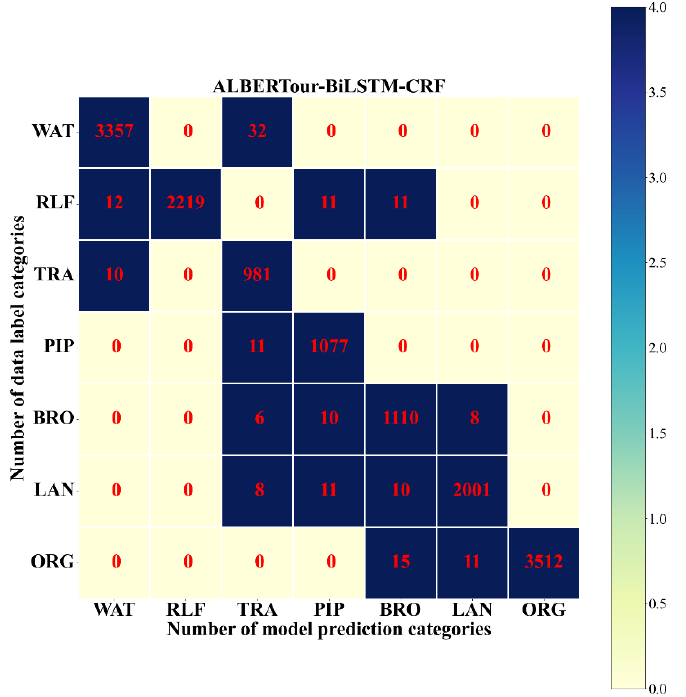
Figure 10. Confusion matrix for all extracted and gold‑standard toponym from the constructed dataset based on ALBERT–BiLSTM–CRF. WAT = water system; RLF = residential land and facilities; TRA = transportation; PIP = pipelines; BRO = boundaries, regions, and other areas; LAN = landforms; ORG = organization.